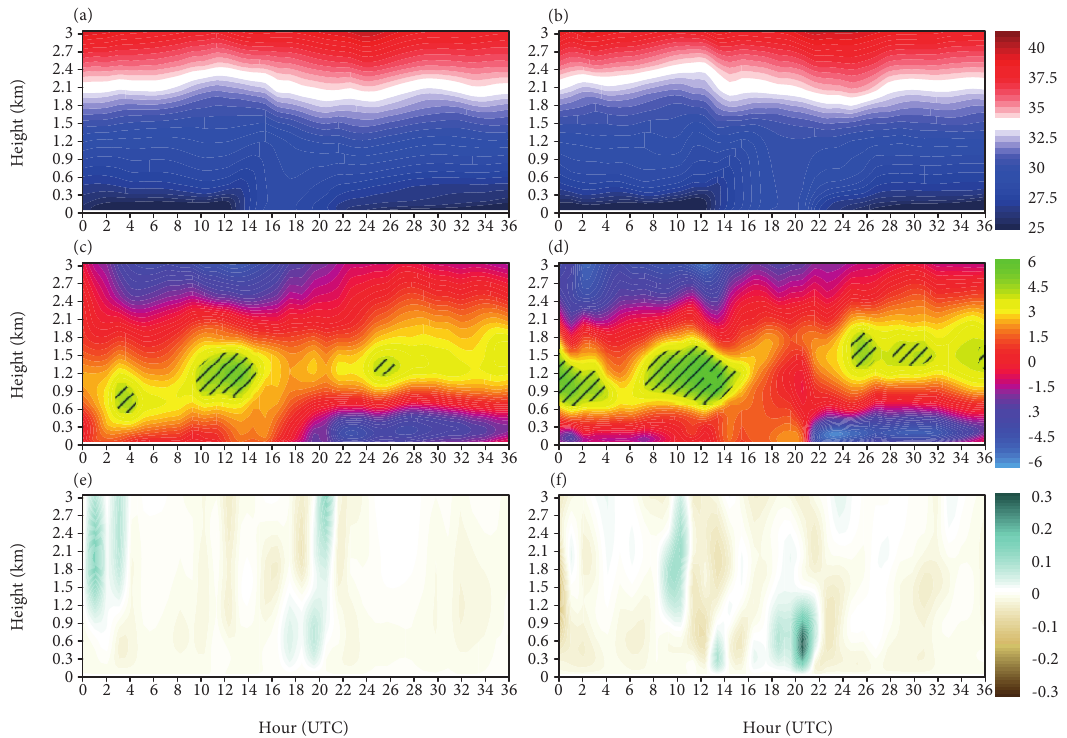
Figure 8. Temporal evolution along transects AB (right) and EF (left) for potential temperature (a, b), meridional wind (c, d), and vertical velocity (e, f). The hatched areas represent maximum values from 4.5 to 6 m.s -1 in the meridional component of the wind.